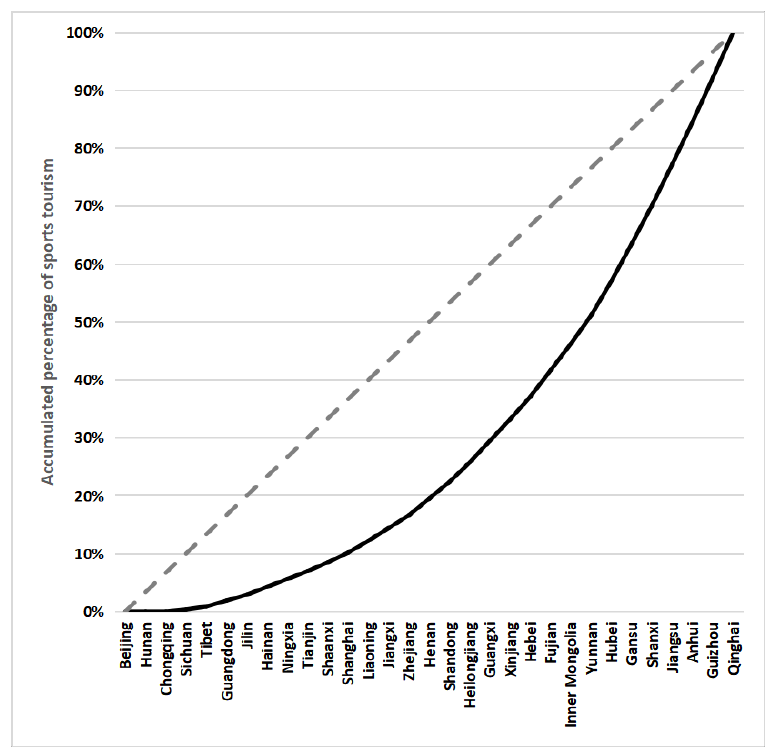
Figure 4. Lorentz curve of the distribution of China's sports tourism resources by province in 2018. ArcGIS 10.2 (ESRI, Inc., Redlands, CA, USA) was applied to analyze the average nearest neighbors of China’s sports tourism resources in 2018. Results show that the average observation distance is 33,333.9247 m, expected average distance is 82,961.2671 m, the nearest neighbor ratio R is 0.401801, Z score is − 27.797295, and the significance level is p < 0.001. Thus, China's sports tourism resources in 2018 show a clear agglomeration distribution in space.